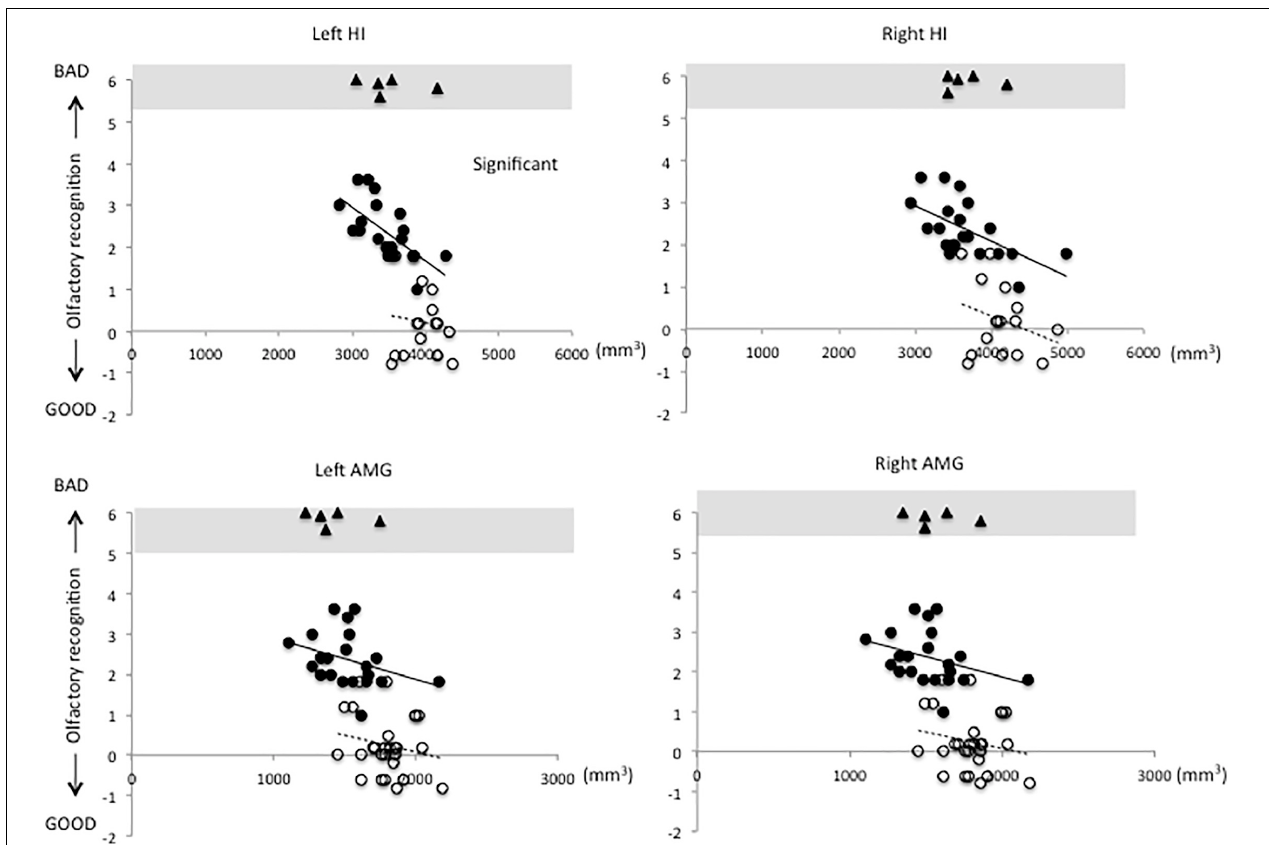
FIGURE 1 | Relationships between volumes of the hippocampus (HI) and amygdala (AMG) and olfactory test scores in elderly and young subjects (elderly subjects, closed circles with solid line; young subjects, open circles with dotted line). A significant group × volume interaction was observed for the left HI. There were no group × volume interactions for any other brain regions (statistical details are included in Supplementary Table 2